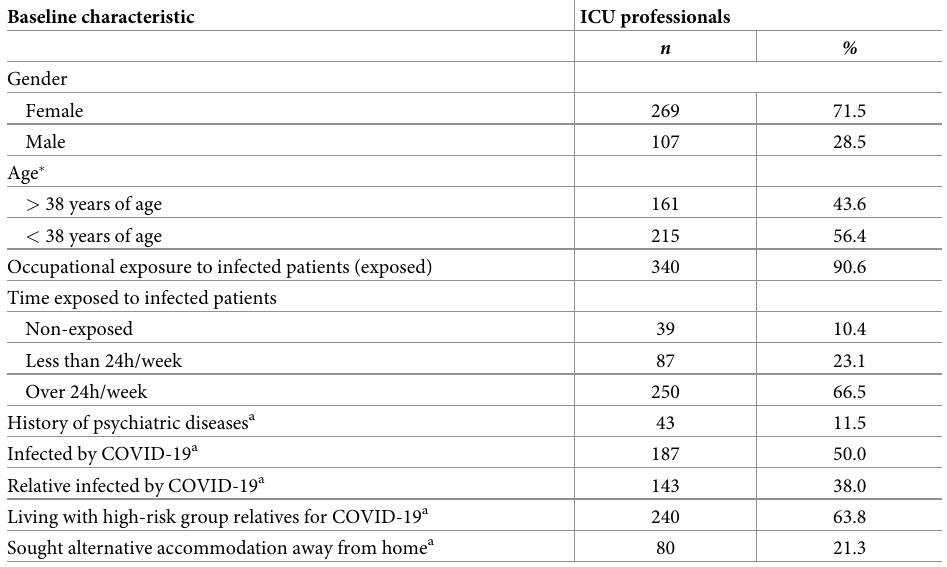
Table 1. Socio demographic, personal, and occupational characteristics of